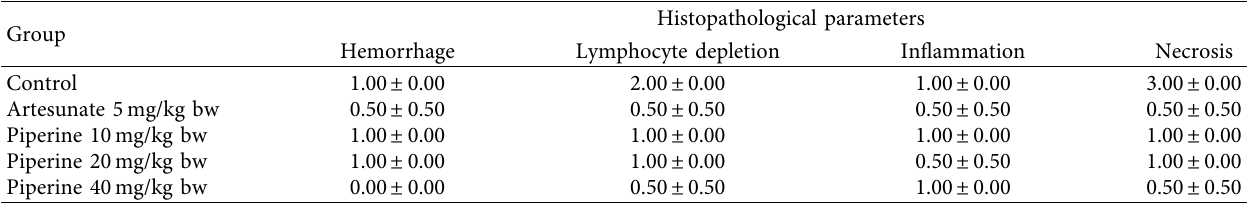
Table 3: Semiquantitative analysis of spleen histopathology in the curative